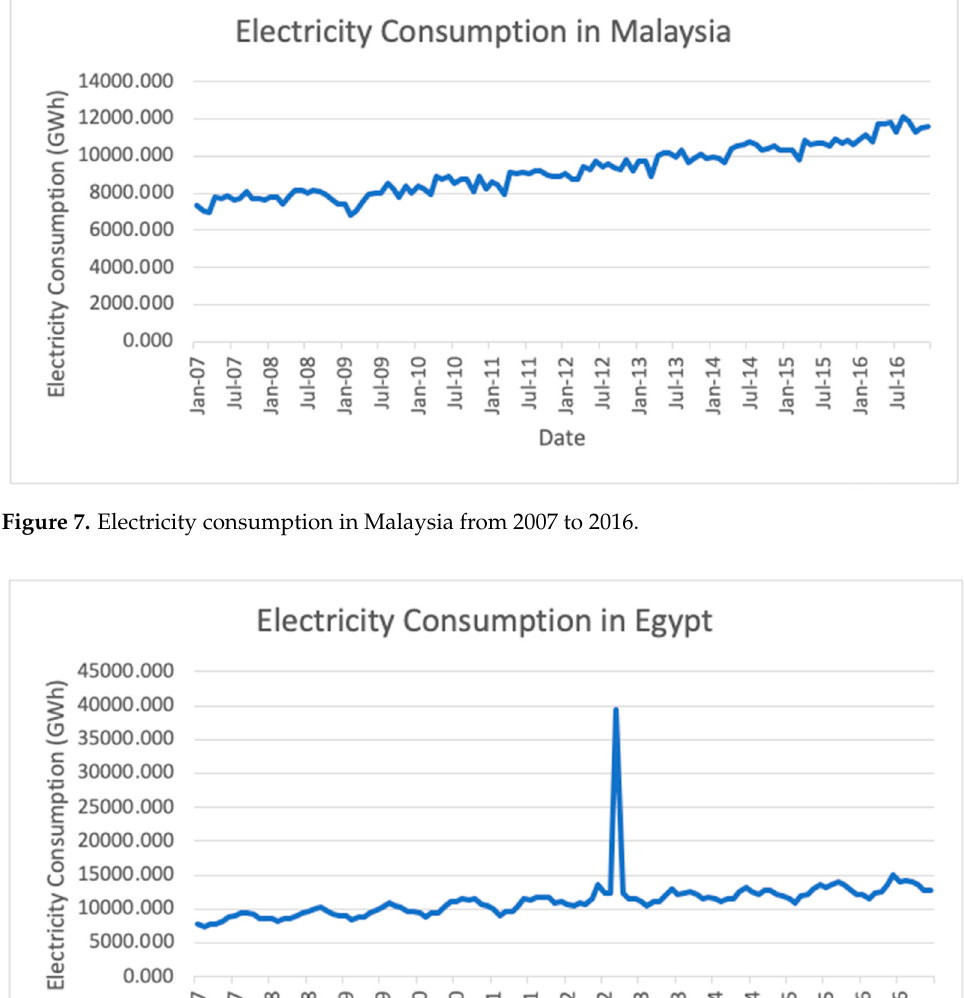
Figure 8. Electricity consumption in Egypt from 2007 to 2016.